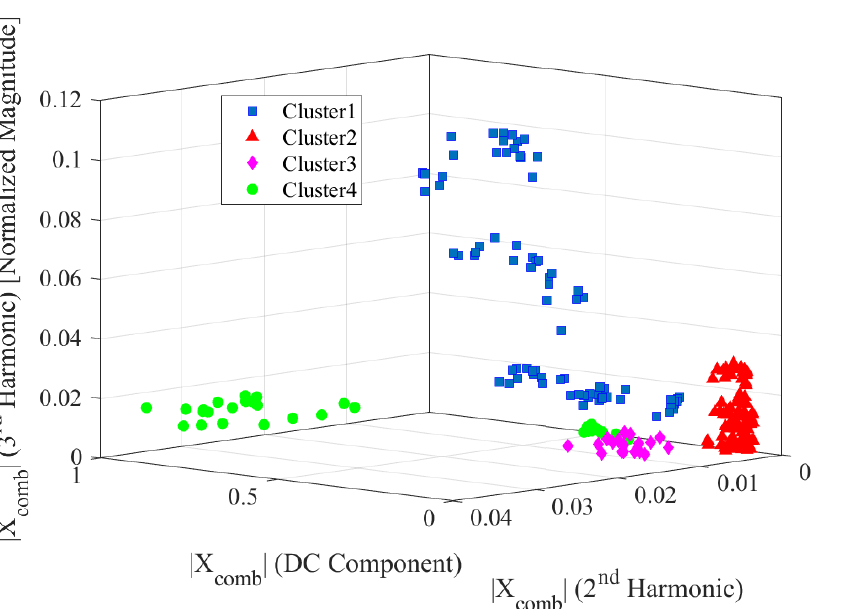
Figure 16. Scatter plot of combined stator voltage and current, and rotor current harmonics as feature